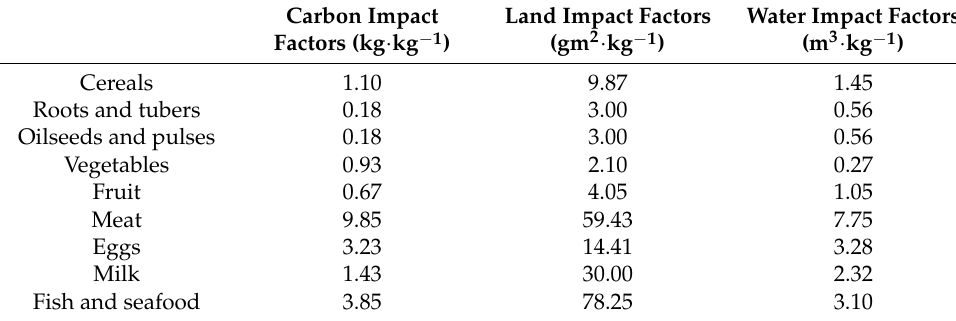
Table 2. Environmental impact factors of different food